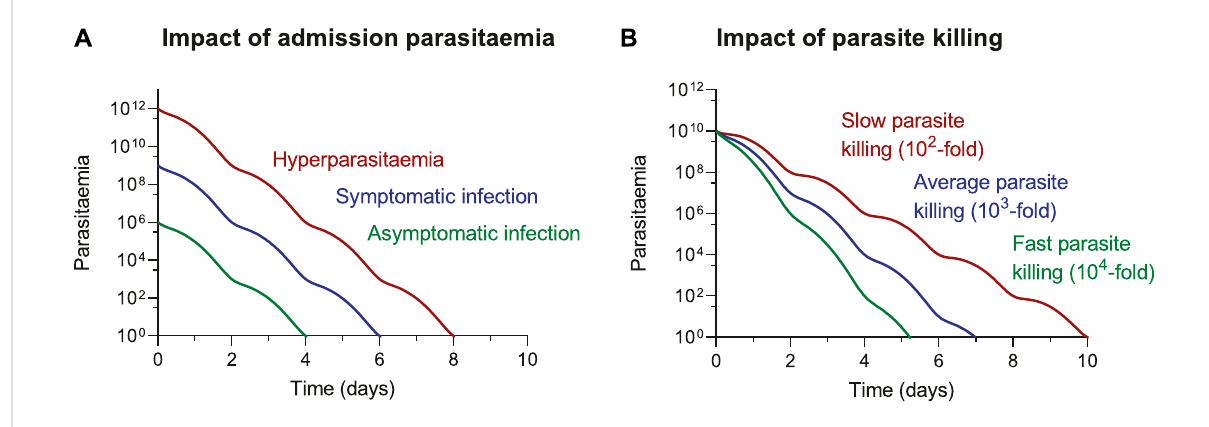
FIGURE 2 ACT-related elimination of a malaria infection, illustrating the impact of (A) starting parasitaemia and (B) rate of parasite decline on time to clearing an infection. The impact of parasitaemia (A) is illustrated assuming a 10 3 -fold reduction in parasitaemia every parasite lifecycle of 48 h. The impact of parasite decline (B) is illustrated assuming an admission parasitaemia of 10 10